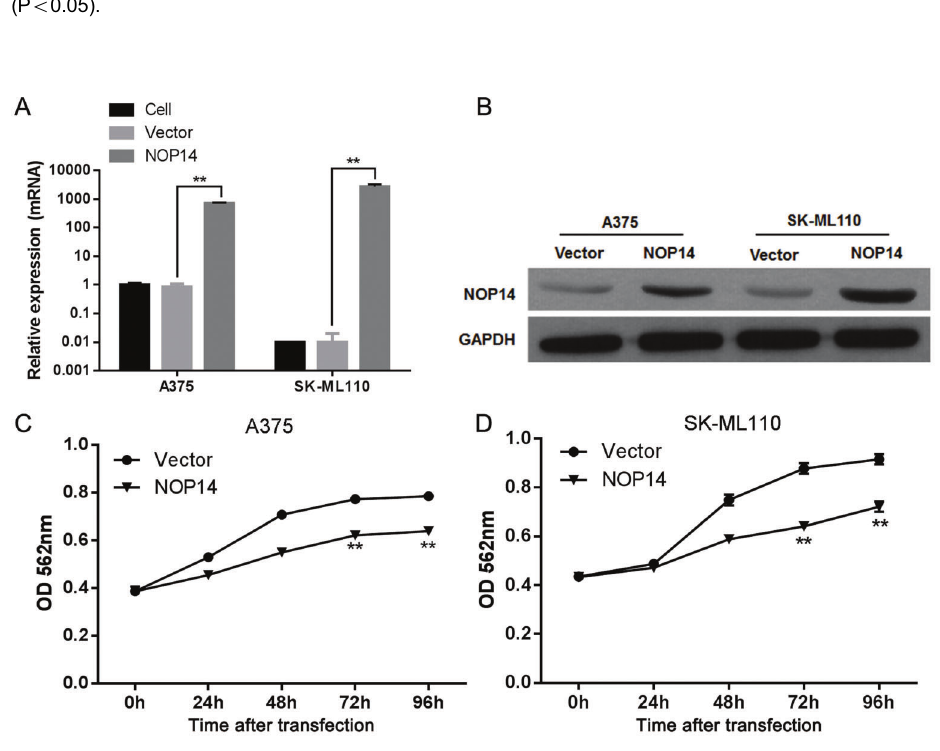
Statistical analyses were carried out with the chi-squared test. Bold type indicates statistical signi fi cance (P o 0.05).